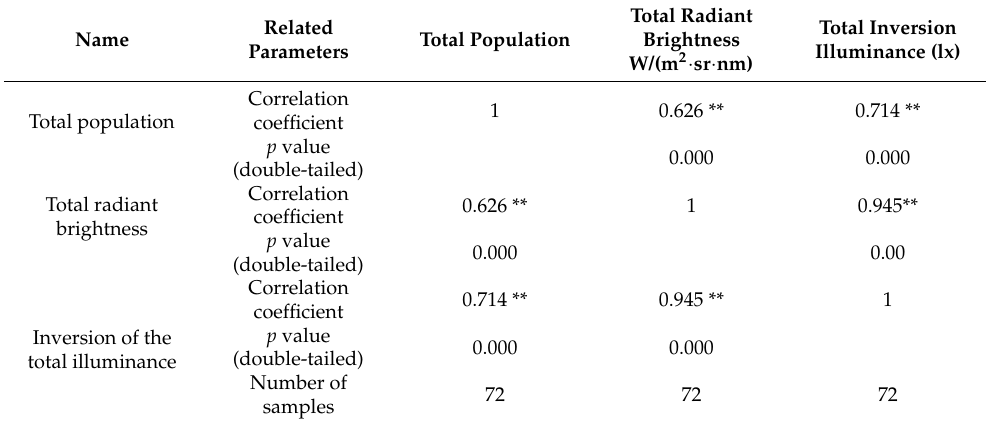
Table 4. Person correlation analysis of total population, radiance and total retrieved illuminance in each